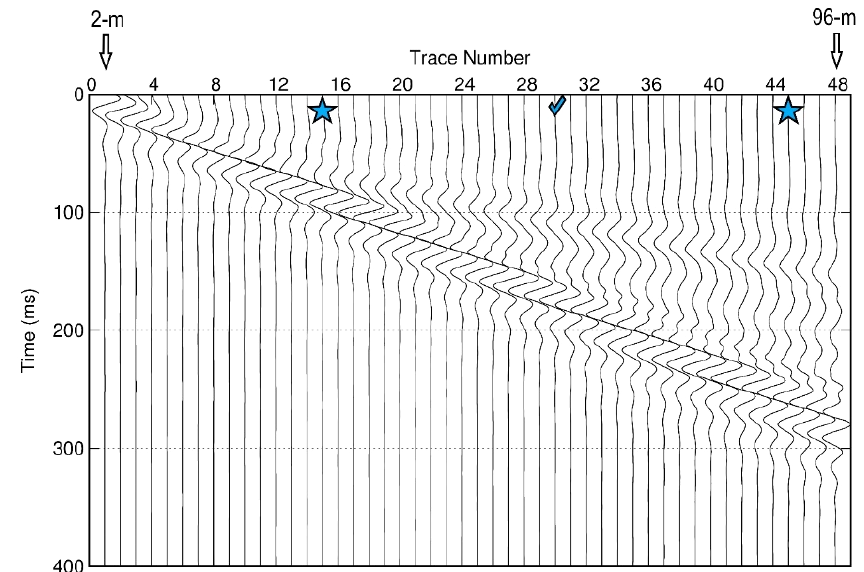
Figure 5. Seismic traces showing P-SV body waves and Rayleigh surface waves corresponding to the model structure in Table 2. See text for more